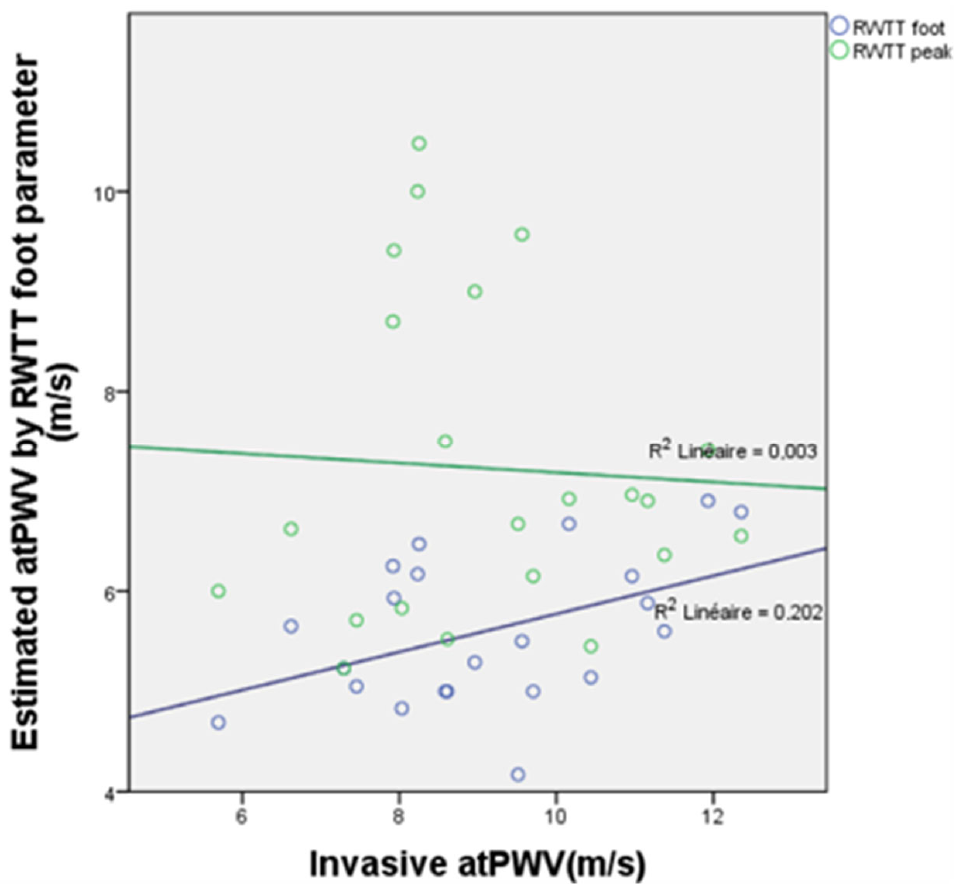
Figure 11. Correlation plot between the invasive aorto ‐ tibial PWV and the RWTT ‐ derived PWV, showing a lack of correlation between both parameters.